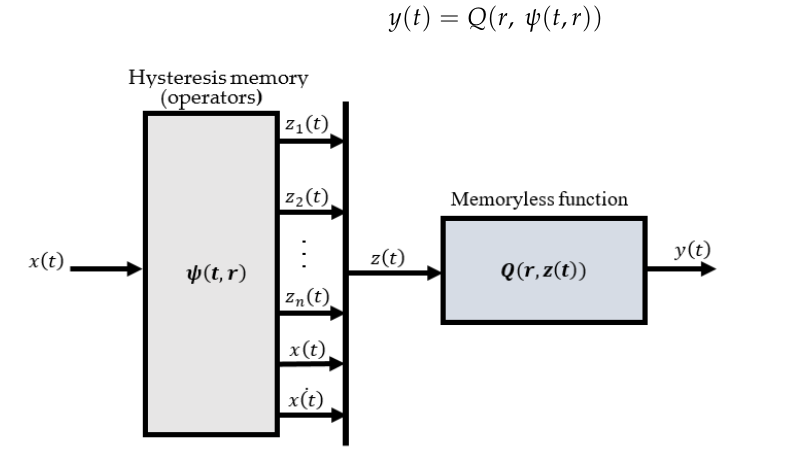
Figure 4. Schematic diagram for Preisach model.